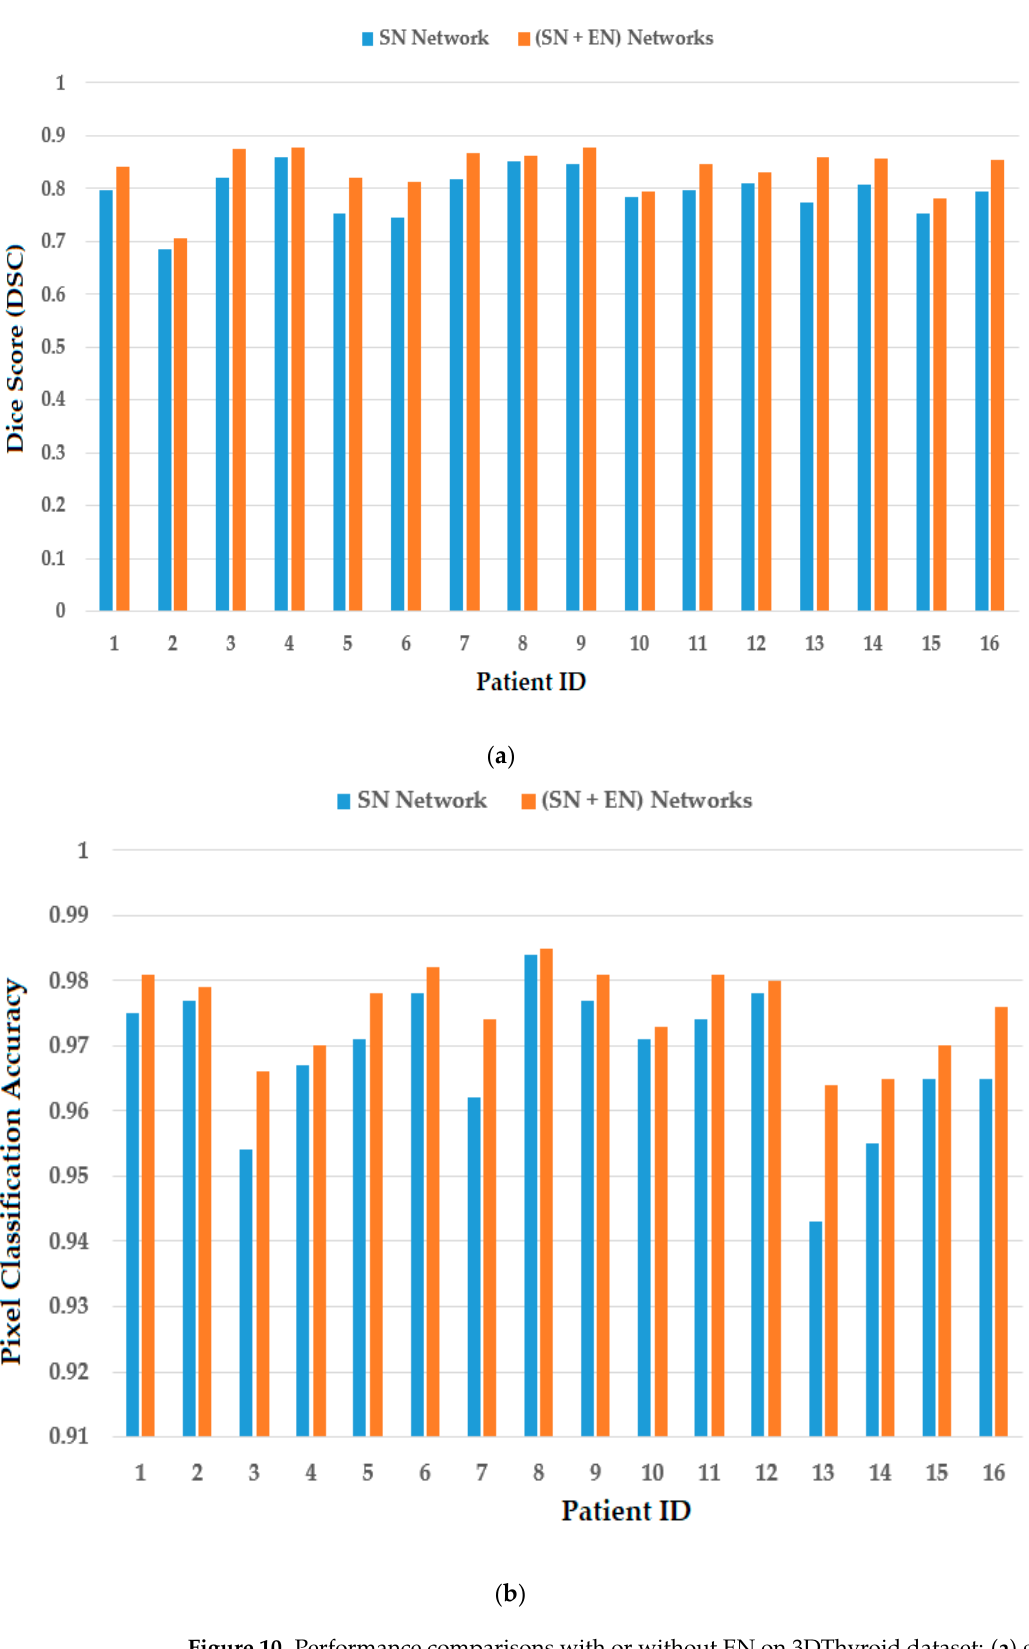
Figure 10. Performance comparisons with or without EN on 3DThyroid dataset: ( a ) graph for DSC; ( b ) graph for pixel classification accuracy (Acc). Table 5. Performance comparisons with or without enhancement network on the TDID dataset .